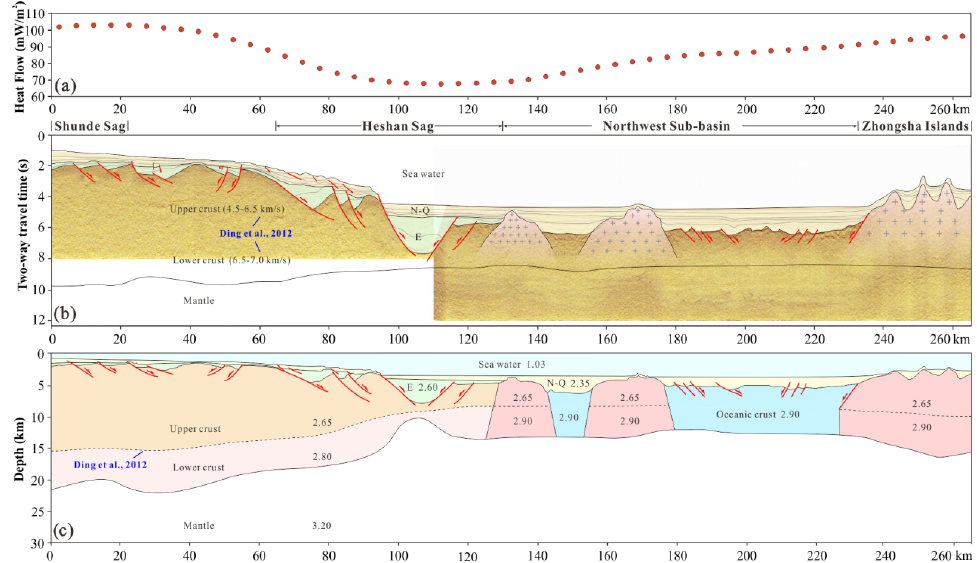
Figure 3. ( a ) The variation of surface heat flow digitized from the heat flow map of Figure 2 along profile L2. ( b ) Crustal structure from the multi–channel seismic reflection profile L2 [26]. The crustal P − wave velocity is from the OBS profiles of OBS2006, which is almost parallel to profile L2 [12] (Figure 1). ( c ) 2D density structure of lithosphere along profile L2 [25,26]. N–Q, late Oligocene–Holocene; E, Paleocene–early Oligocene. See Figure 1 for locations.